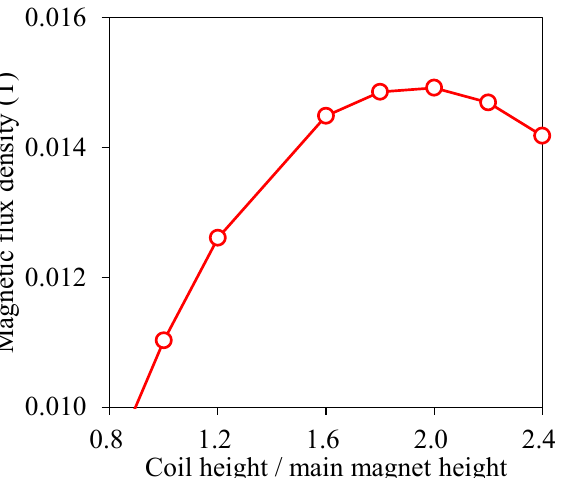
Figure 7. Variation of magnetic flux density according to the ratio of the coil height ( h c ) to the main magnet height ( h m ).